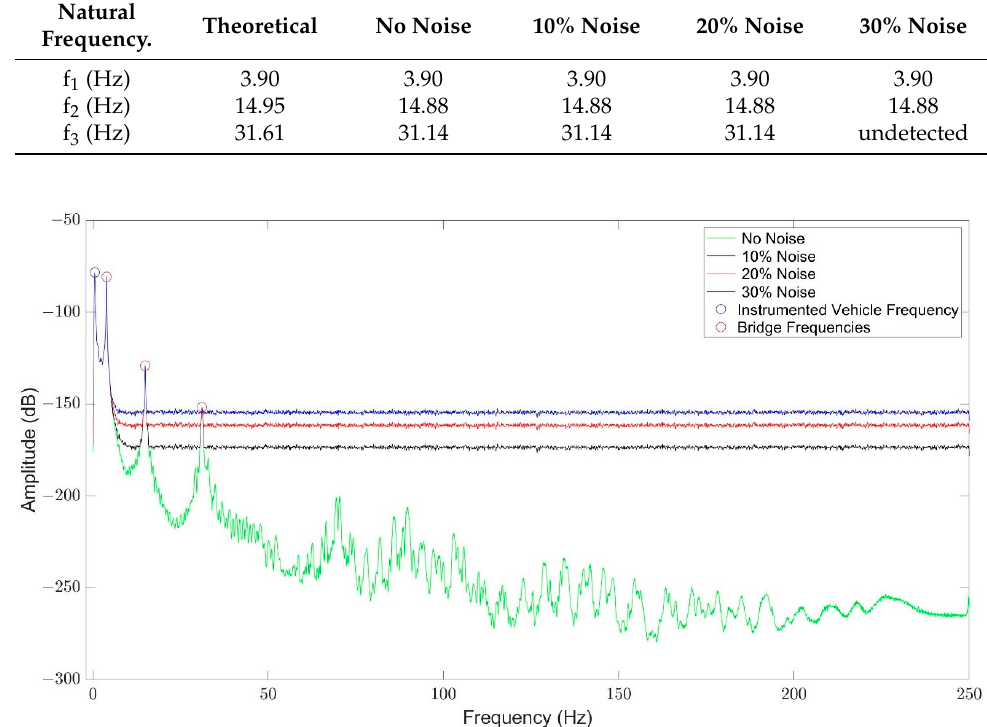
Table 6. Comparisons between the theoretical natural frequencies of the bridge and the identified values in the presence of road roughness (Class A) and increasing noise levels affecting the data. Natural Frequency.